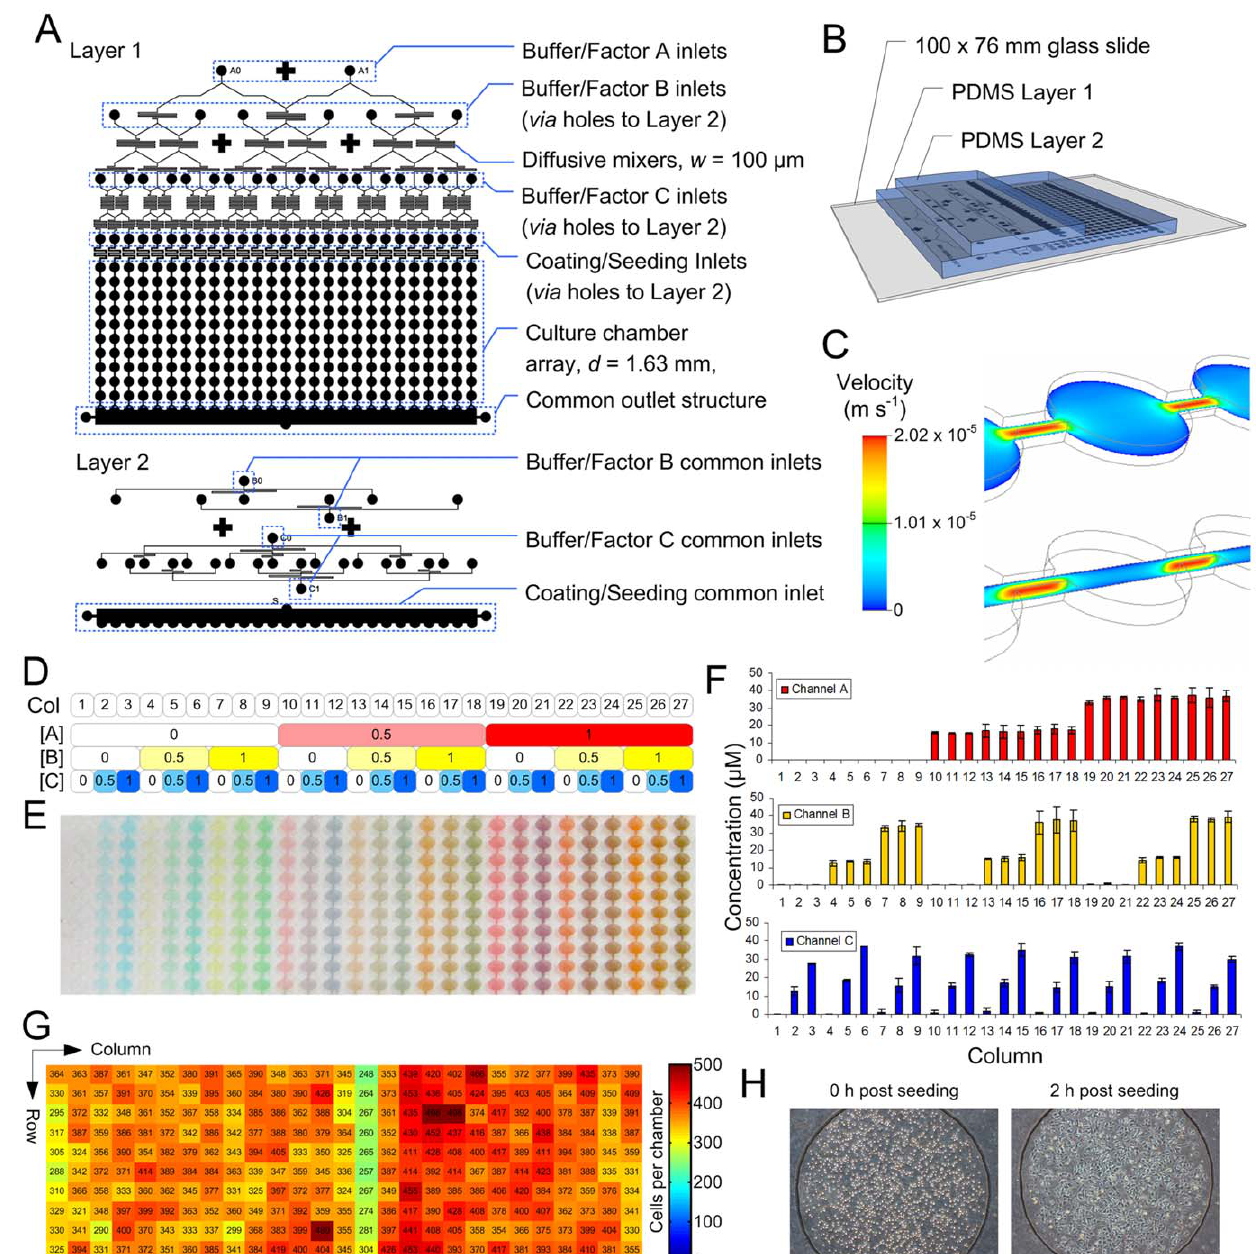
Figure 1. Microbioreactor array design and validation. A Microbioreactor array photomask design, with key features marked. B Perspective schematic view showing assembly of glass substrate and PDMS structural layers 1 and 2. Via holes join microchannel structures between layers. C Computational fluid dynamic model of velocity field through centreline planes at nominal operating conditions. Chambers are 1.63 mm in diameter and 250 m m high. D Design normalised concentrations of factors in each column, corresponding to panels E and F. Stock factor and buffer solutions are provided at normalised concentrations of 3 and 0, respectively, to allow for subsequent dilution. E Photograph of microbioreactor array filled with red, yellow and blue food dyes (representing factors A1, B1 & C1, respectively), and mixed with PBS (buffers A0, B0, & C0). F Fluorimetric quantification of soluble factor levels in each column. Stock solution of 40 kDa FITC-dextran was provided at 100 m M, therefore the design concentration levels are 0, 16.7 and 33.3 m M. Bars represent mean 6 SD of 2 independently fabricated devices. G Heatmap of number of nuclei in each chamber, with individual numbers marked. Cell numbers do not represent densities used in microbioreactor experiments. H Phase contrast images of hESCs imaged 0 and 2 h after seeding into microbioreactor arrays. Chambers are , 1.63 mm in diameter. residual adsorbed dye. The accurate generation of all concentra- Hoechst-labelled cells and image analysis to count nuclei, which tion levels also implied the flow distribution across the device was showed acceptably uniform cell distribution throughout the array in agreement with design flowrates and therefore equal between (coefficient of variation 10.7%, Figure 1G). Cell attachment was columns. Cell seeding uniformity was also evaluated using fixed, also assessed by seeding live hESCs into arrays, which revealed